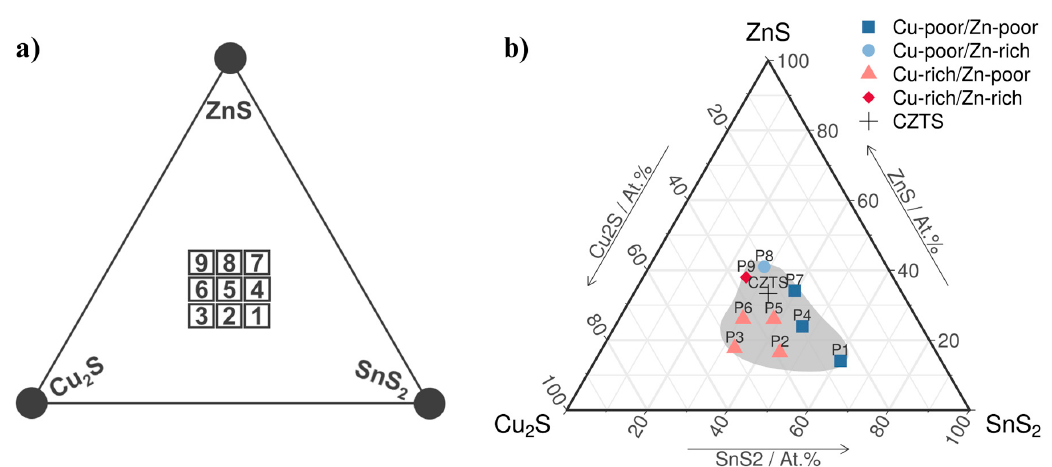
Figure 1. Experimental configuration of the samples and the obtained compositions: ( a ) the positions of the binary targets (circles) and glass substrates (squares) during the magnetron co-sputtering deposition of the Cu 2 S–ZnS–SnS 2 thin films; and ( b ) the average chemical composition calculated from